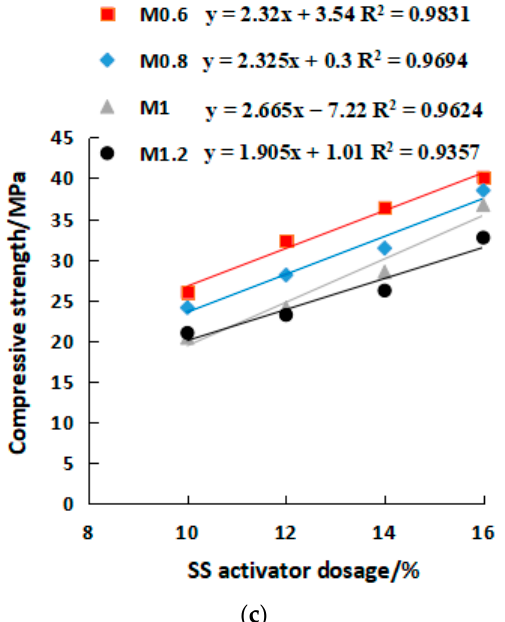
Figure 10. Relationship between compressive strength and SS activator dosage. ( a ) 3 days, ( b ) 7 days, ( c ) 28 days.